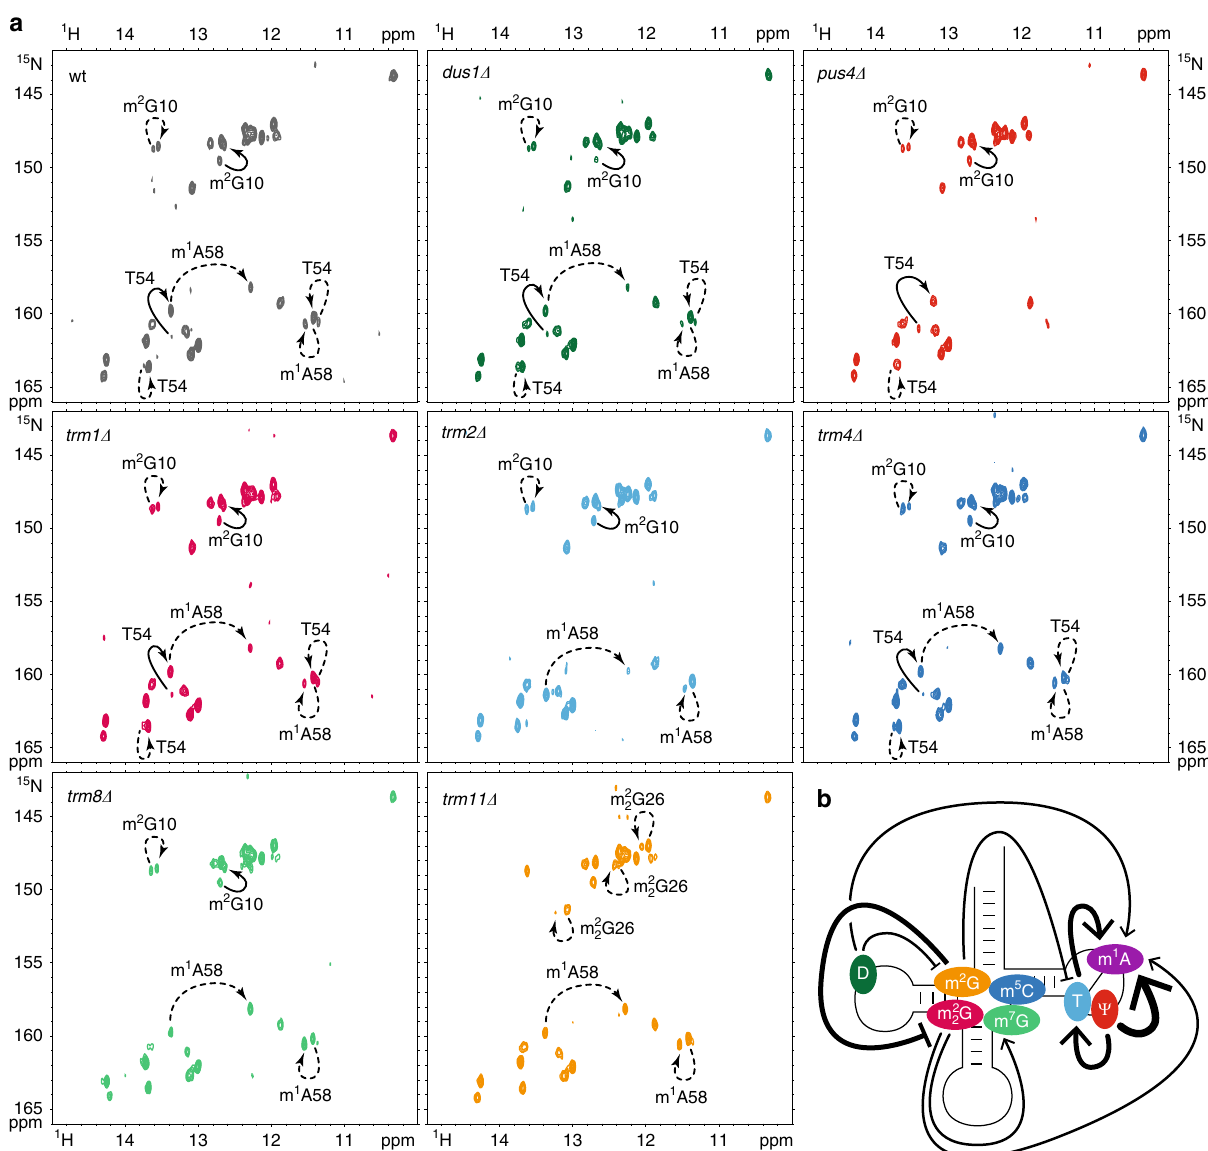
quanti fi cation in total tRNAs (Fig. 6a, b) re fl ects the sum of the